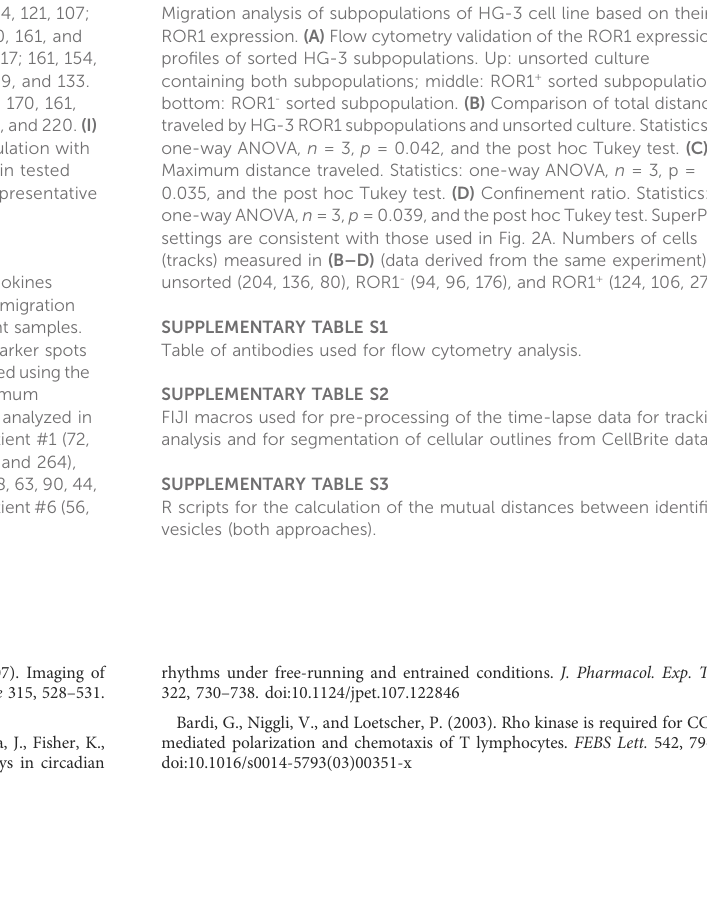
SUPPLEMENTARY FIGURE S9 Migration analysis of subpopulations of HG-3 cell line based on their ROR1 expression. (A) Flow cytometry validation of the ROR1 expression pro fi les of sorted HG-3 subpopulations. Up: unsorted culture containing both subpopulations; middle: ROR1 + sorted subpopulation, bottom: ROR1 - sorted subpopulation. (B) Comparison of total distance